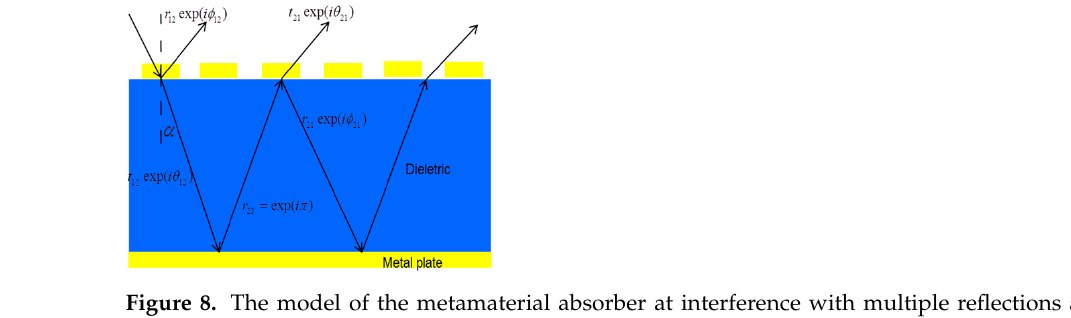
Figure 8. The model of the metamaterial absorber at interference with multiple reflections and transmission [18].